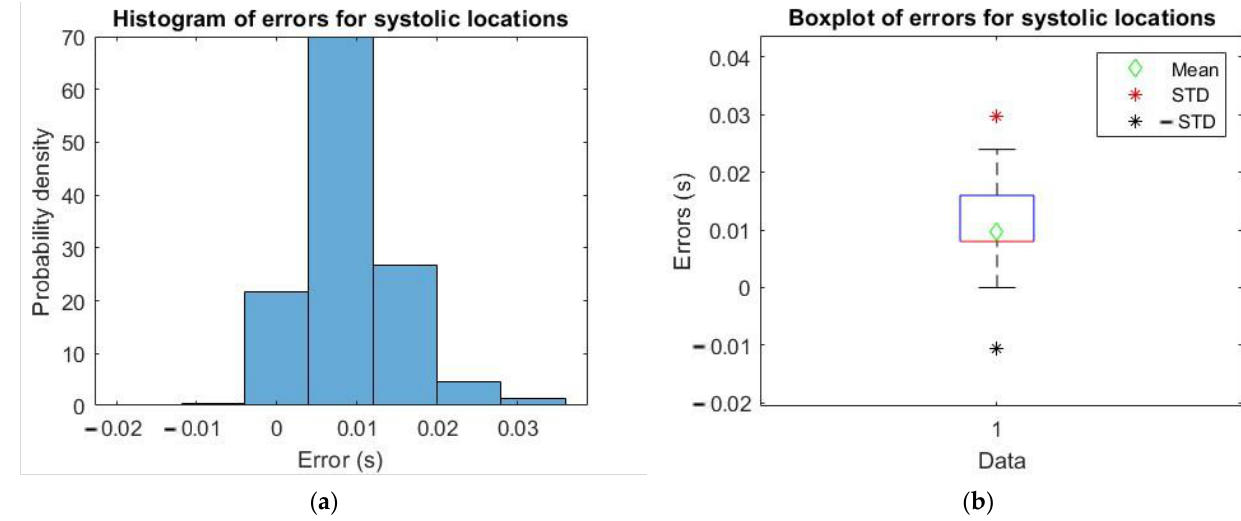
Figure 7. ( a ) Histogram of errors for systolic locations; ( b ) boxplot of errors with mean, mean + std and mean −